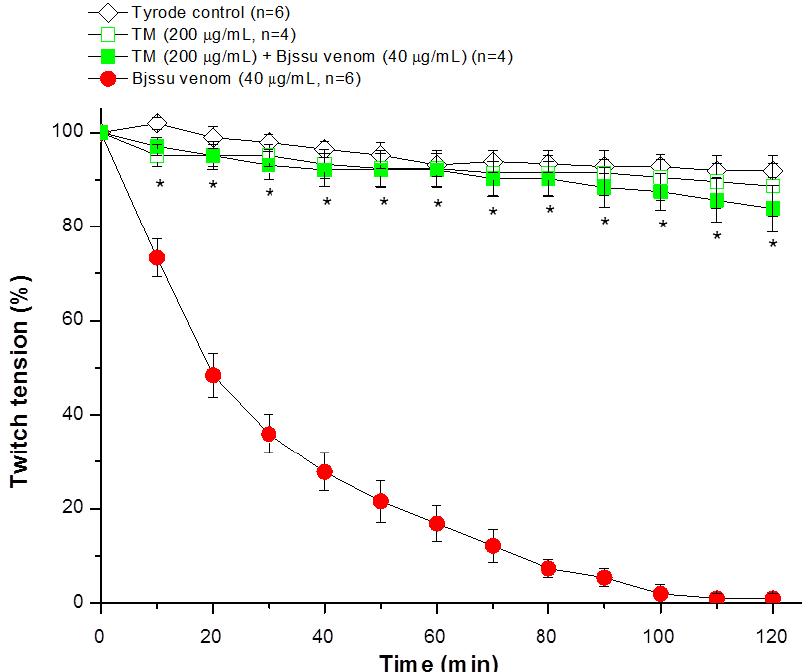
Figure 2. Twitch tension responses of indirectly stimulated PND incubated with 7,8,3'-trihydroxy-4'-methoxyisoflavone (TM, 200 μ g/mL), B. jararacussu (Bjssu) venom (40 μ g/mL) or a mixture of TM (200 µg/mL) and venom (40 μ g/mL). The TM + venom mixture was preincubated at 37 °C for 30 min prior to testing. The points are the mean ± SEM of the number of experiments indicated in the figure. * p < 0.05 for TM + venom compared to venom alone.